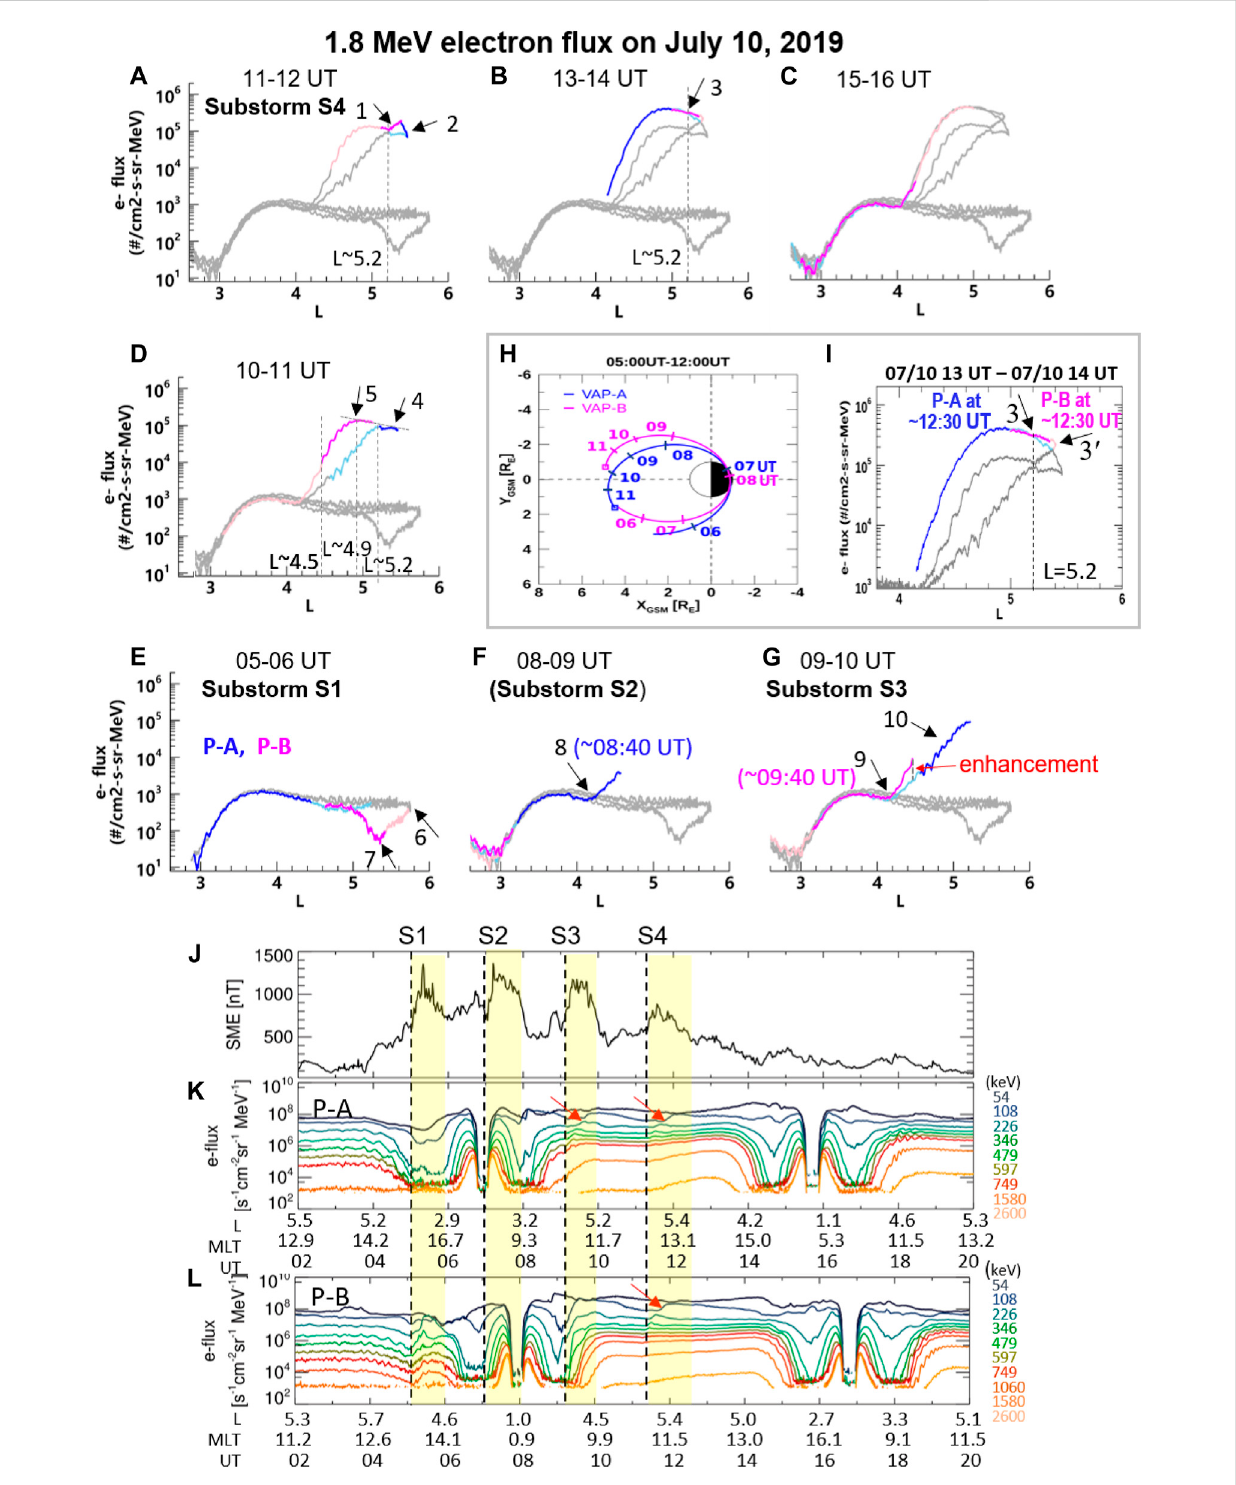
FIGURE 2 (A – G) Hourly snapshots for 1.8 MeV electron fl ux for 7 different hours during 05 – 16 UT, which use spin-averaged electron fl ux from REPT (Relativistic electron Proton Telescope; Baker et al., 2012) instrument. Here, L is McIlwain ’ s L-parameter provided in the RBSP-ECT (Radiation Belt Storm Probes-Energetic Particle Composition and Thermal Plasma) data, while our results are not affected by using the also provided Roederer ’ s L*. (H) Locations of Van Allen Probes A and B for 05-12 UT inthe GSM coordinates. (I) A closer view of the13-14UT snapshot in (B) . (J) SME. (K, L) 90 ° pitch angle electron fl uxes from MagEIS instrument onboard P-A and P-B,